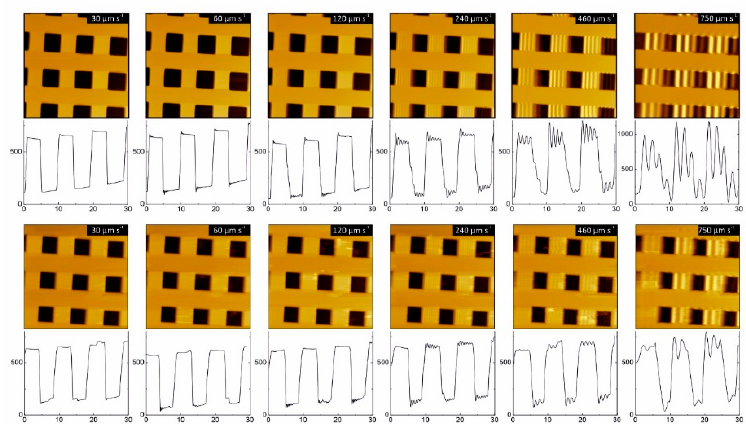
Figure 4. Comparison of speed performance in different media. The upper part shows images acquired in deionized water, and the lower part in pure human blood. The speed has been increased from 30 μ m/s (1 s/line) to 750 μ m/s (0.04 s/line). The corresponding horizontal cross ‐ sections have been extracted from the very same position in the middle row of the image. Measurements have been performed on a HS ‐ 500MG AFM XYZ calibration standard. x , y scan range is 30 μ m for all images.